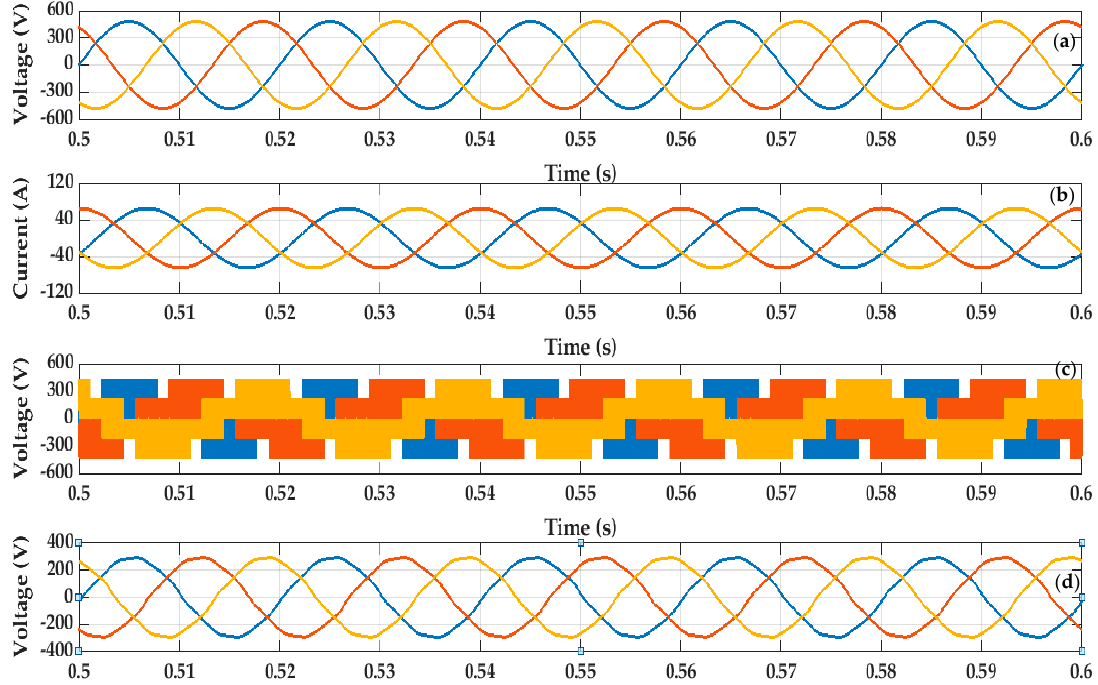
Figure 8. Simulation waveforms of the drawn voltage and current from the grid to charging station: ( a ) input three-phase voltages, ( b ) input three-phase currents, ( c ) three-phase voltage waveforms of AC fast charging before LC filter, ( d ) three-phase voltage waveforms of AC fast charging after LC filter.